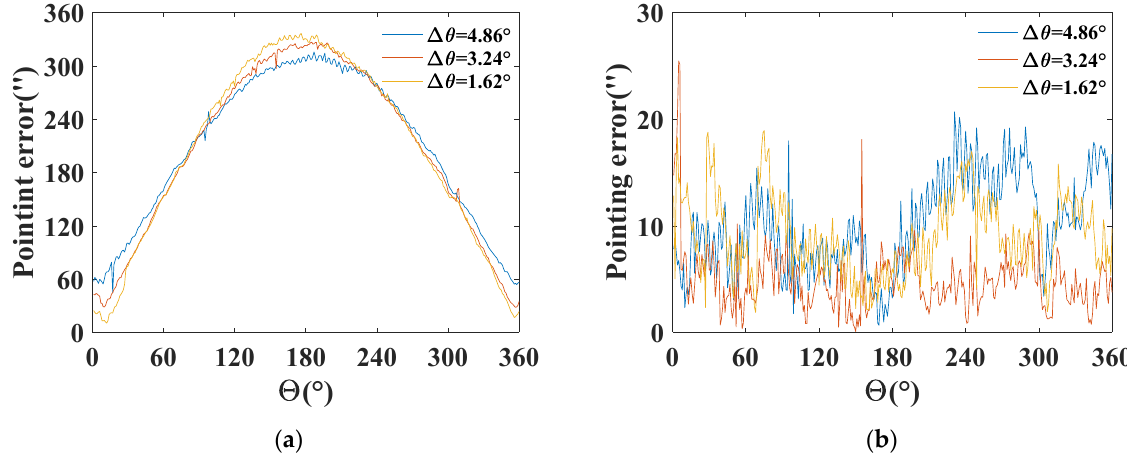
Figure 12. Comparison of the forward solution errors before and after correction in the experiment. ( a ) Before correction. ( b ) After correction.